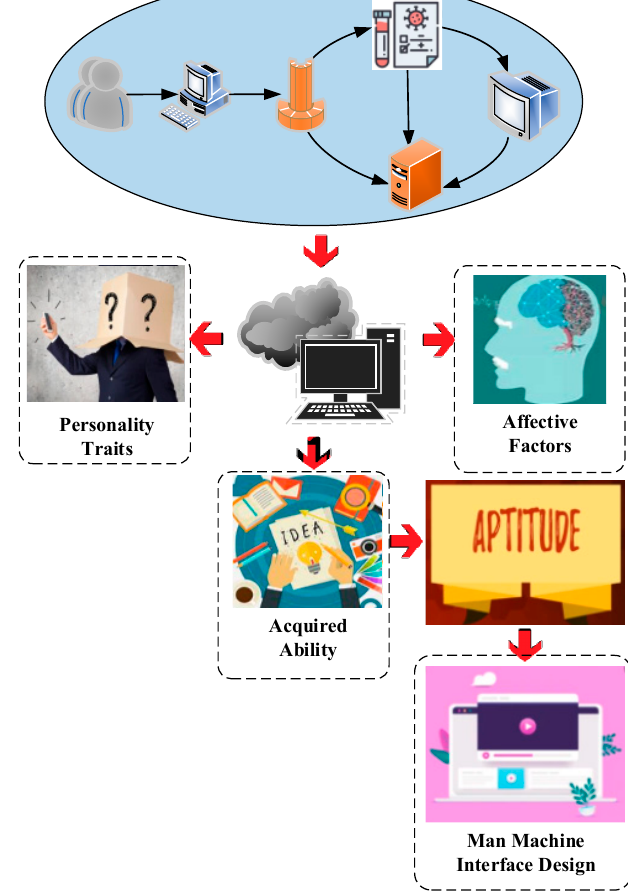
Figure 2. Research framework of intelligent HCI design.